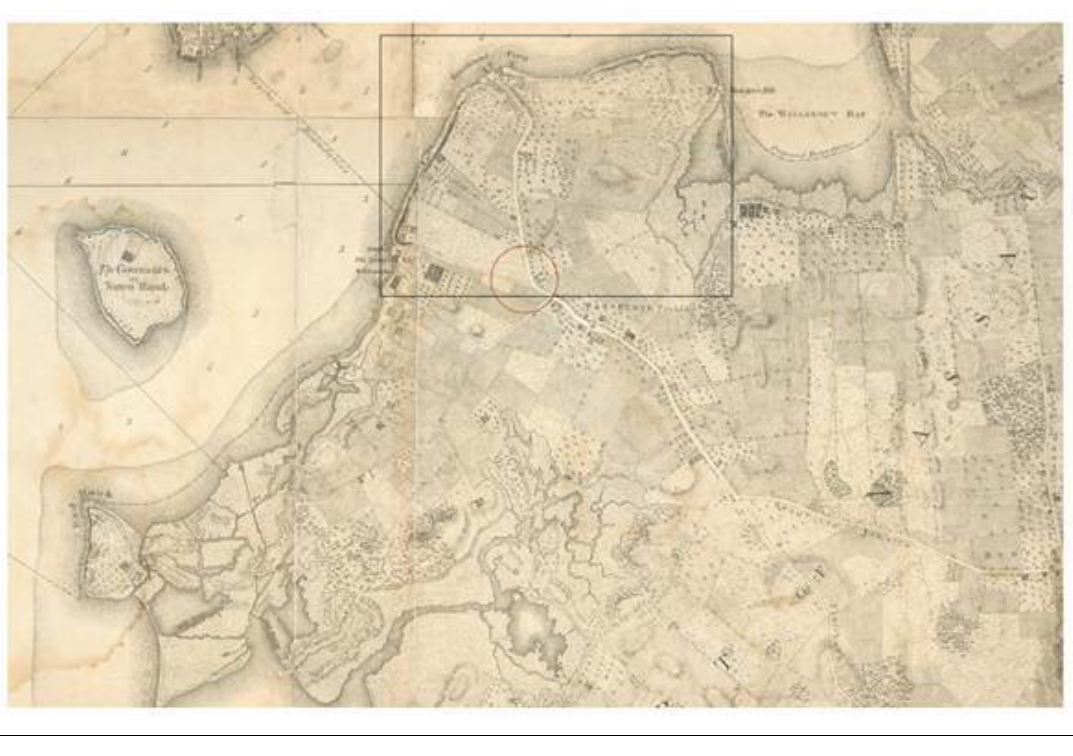
Figure 4. Pre-urban territory in 1767 with rectangle marking area of initial urban plan. The red circle indicates the future location of City Hall (Source: New York Public